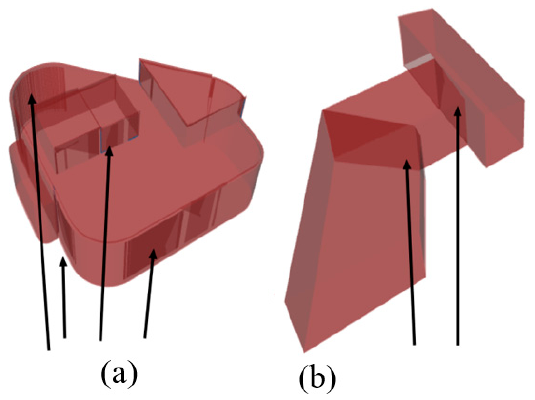
Figure 10. ( a ) Lotsen, a complicated building model and ( b ) Myran, a simpler example with correct solid translation.